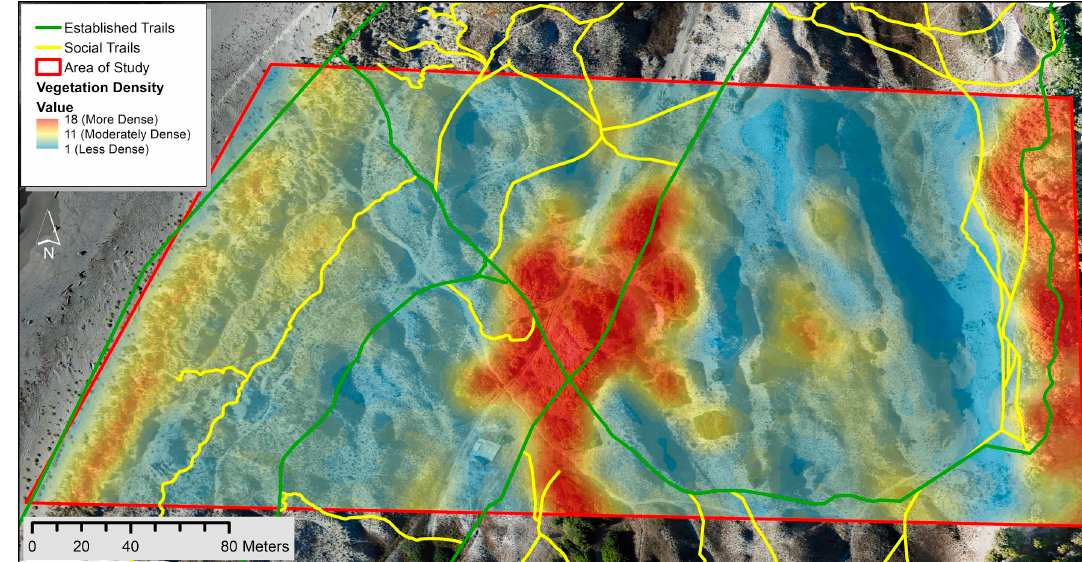
Figure 3. Vegetation density within the study site overlaid with both established and social trails digitized through unmanned aerial vehicle (UAV) imagery.